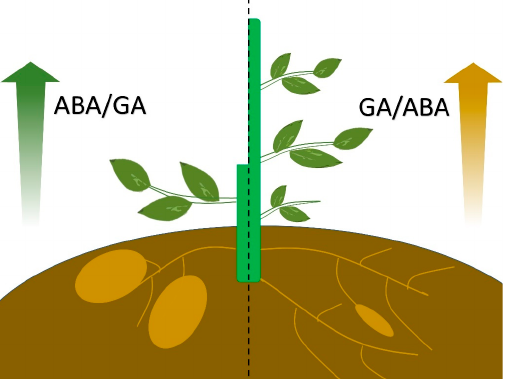
Figure 3. A model showing the antagonistic role of GA and ABA during tuber development. A higher ABA/GA ratio leads to the tuberization, while a higher GA/ABA ratio results in longer stems and delayed tuberization.